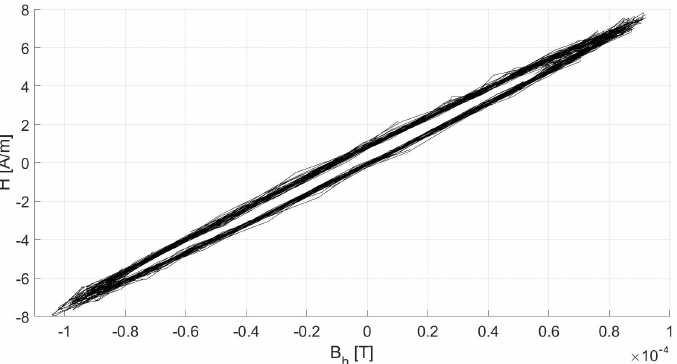
Figure 5. A hysteresis loop obtained for the strips during the experimental